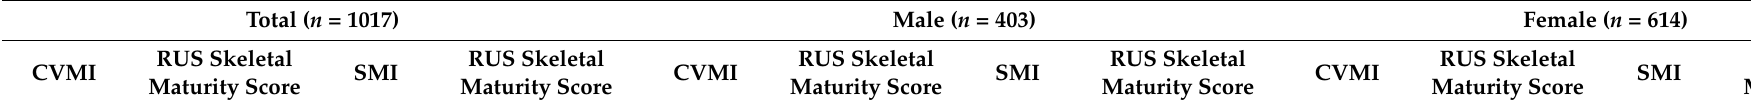
Table 4. RUS skeletal maturity scores associated with the SMI and